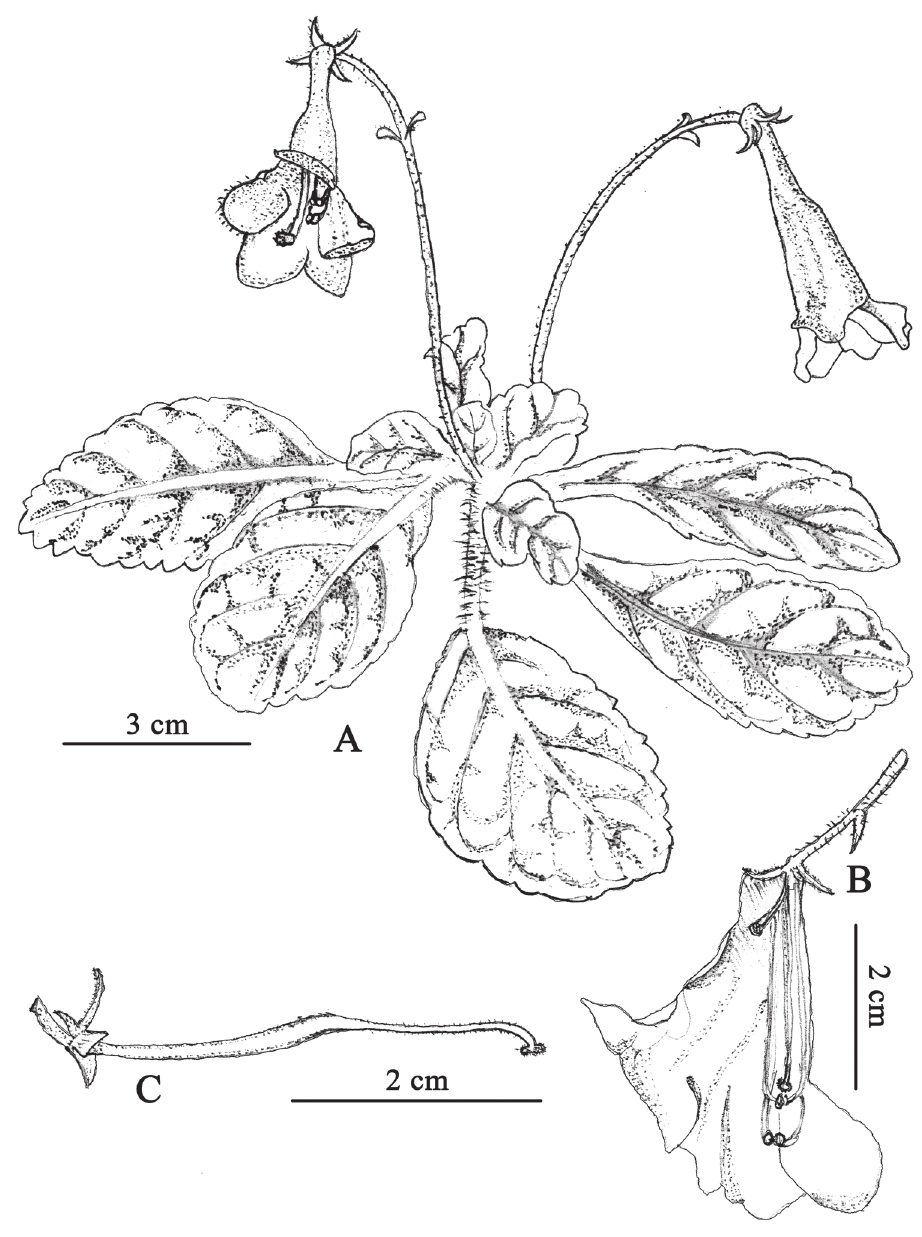
Figure 3. Oreocharis grandiflora W.H.Chen, Q.H.Nguyen & Y.M.Shui, sp. nov. (all drawings based on the holotype Y.M. Shui et al. B2013-550 in KUN, drawn by Y.F. Shui) A Habit B Opened corolla show- ing corolla lobes and two pairs of stamens C pistil at stigma receptivity and